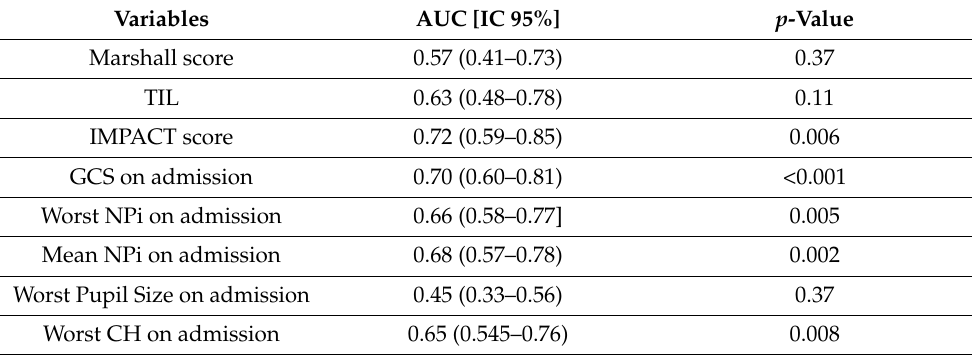
Table 2. Receiving Operating Characteristics (ROC) Curves to predict unfavourable neurological outcome at hospital discharge. NPi = Neurological Pupil Index; CT= Computed Tomography; CH = Change (percentage of constriction); GCS =Glasgow Coma Scale; IMPACT = International Mission for Prognosis and Analysis of Clinical Trials in TBI; TIL = Therapy Intensity Level.